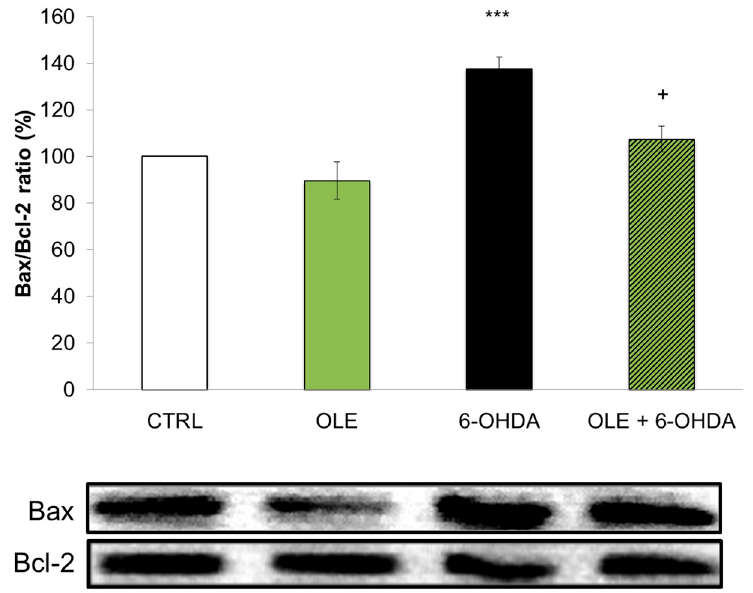
Figure 2. OLE modulates the expression of Bax/Bcl-2 ratio. CTRL and OLE conditions do not show modulation of the pro-apoptotic Bax/anti-apoptotic Bcl-2 ratio. Treatment with 40 µM 6-OHDA for 24 h significantly increases the Bax/Bcl-2 ratio whereas a 3 h pre-treatment with 10 − 12 M OLE prevents this increment. Bottom: Bax and Bcl-2 bands, as revealed by Western blotting. Bax and Bcl-2 optical densities were measured on the same membrane. Ratios were performed between Bax and Bcl-2 of the same condition. Data are expressed as means ± SEM, n = 3. *** p < 0.001 compared with CTRL; and + p < 0.05 compared with 6-OHDA.